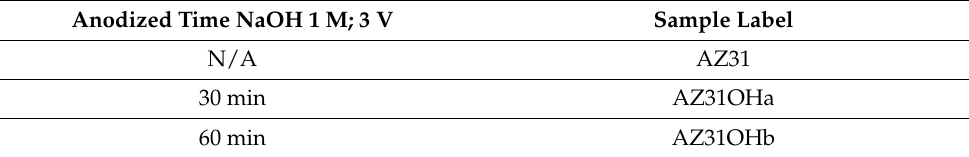
Table 1. Summary of anodised samples.